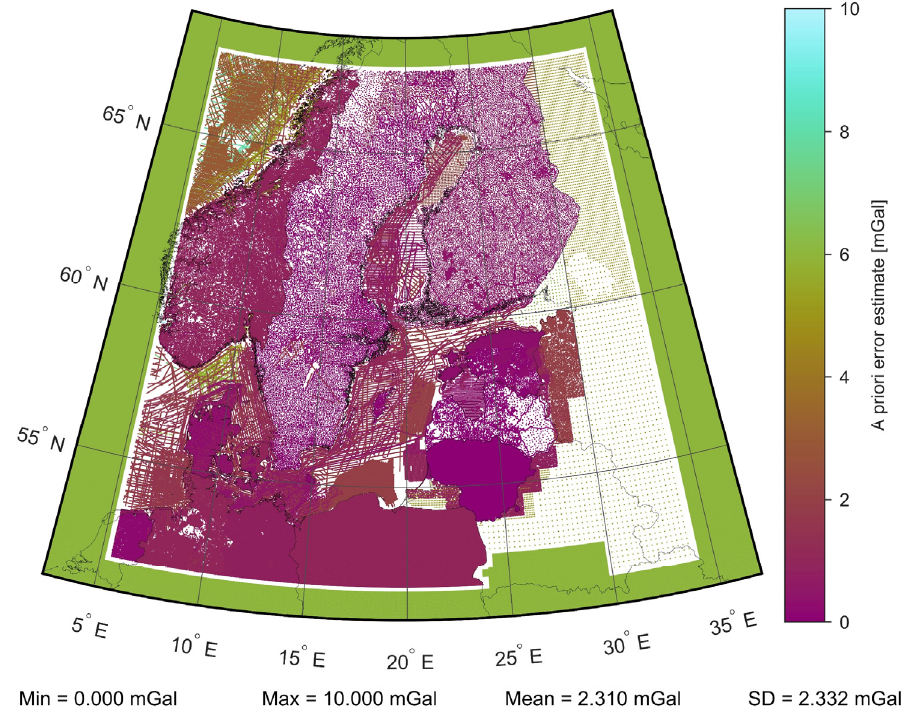
Figure 5. A priori error estimates of gravity data.